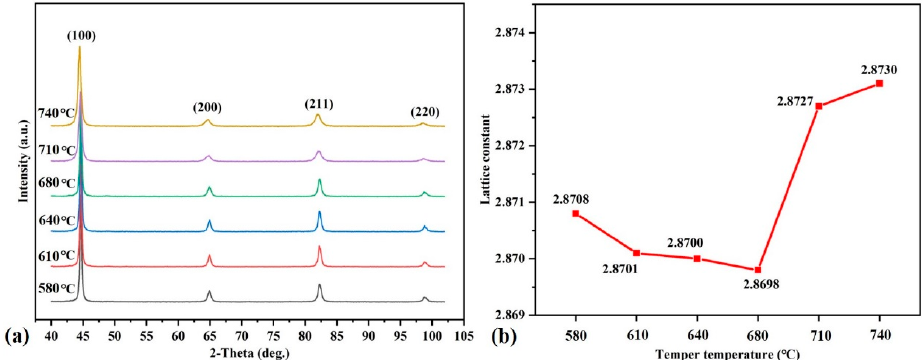
Figure 10. XRD pa tt erns ( a ) and the la tt ice constant of alpha-Fe ( b ) of 35CrMo steel at di ff erent tem- Figure 10. XRD patterns ( a ) and the lattice constant of alpha-Fe ( b ) of 35CrMo steel at different pering temperatures. tempering